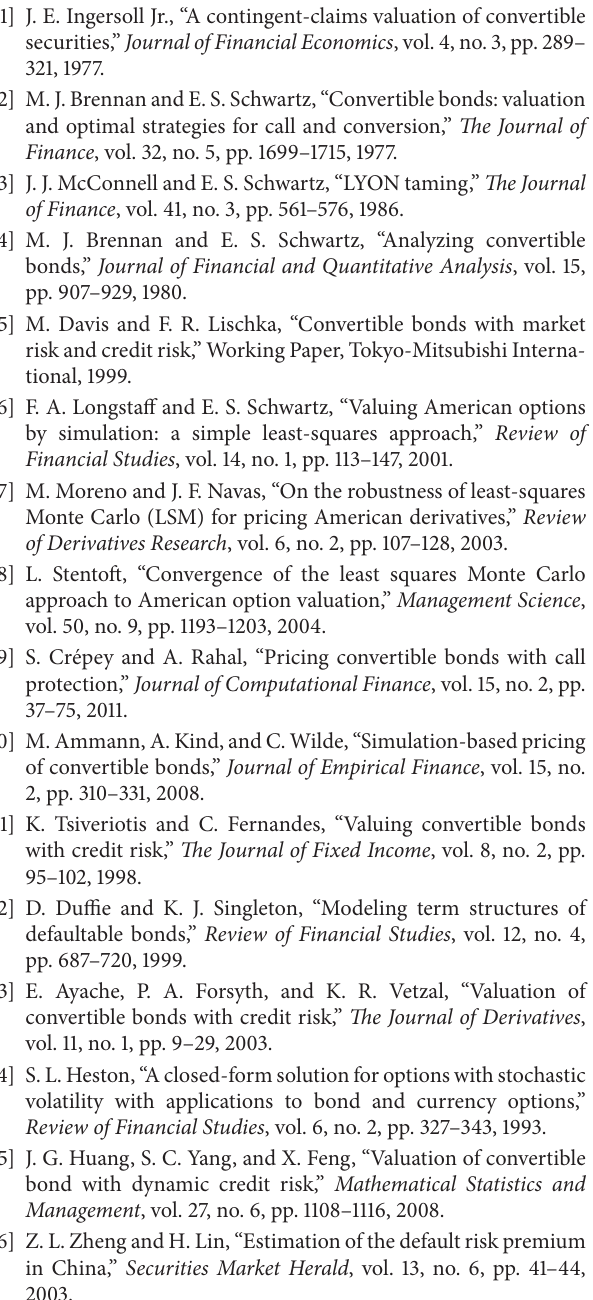
Figure 4: Pricing results without changing the conversion price.